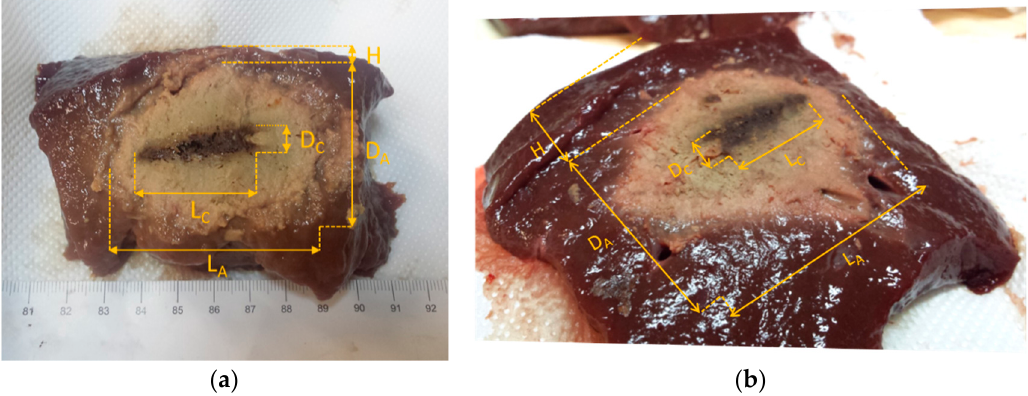
Figure 6. Characteristic dimensions of the zone of ablation in a coronal plane as appraised from the visual inspection. ( a ) Vivaldi experiment. ( b ) Half-heart experiment. The yellow dotted lines denote the position of interfaces of interest, while the two-way arrows identified distances.